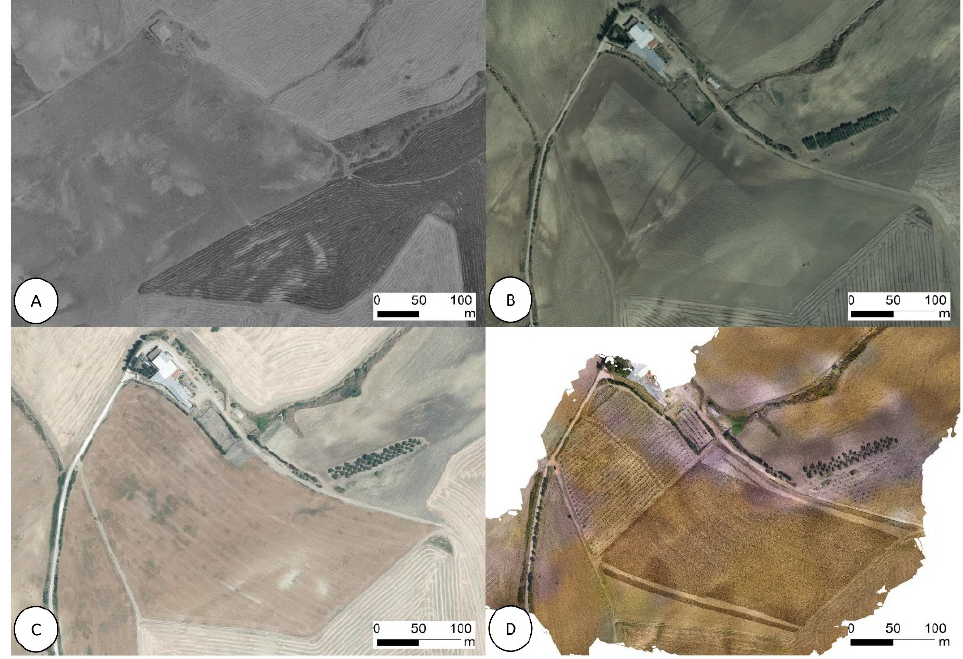
Figure 9. Land use changes in the study area: ( A ) 1974; ( B ) 2013; ( C ) 2017; ( D ) 2020.